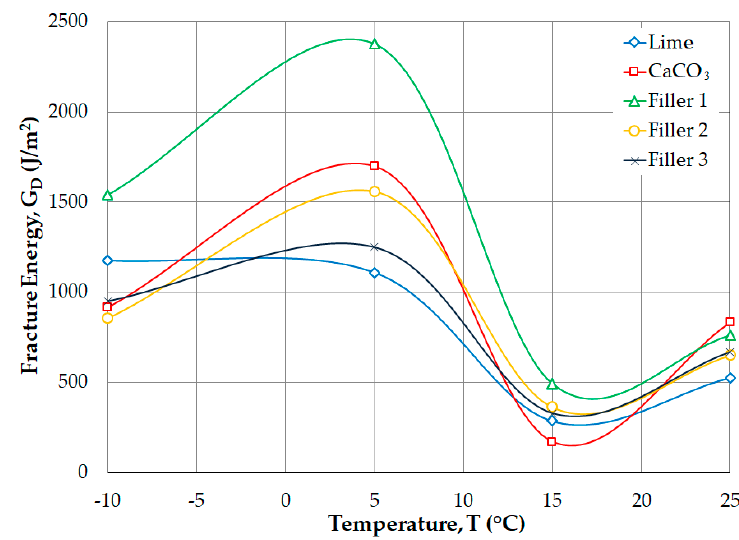
Figure 9. Fracture energy ( G D ) as a function of test temperature.